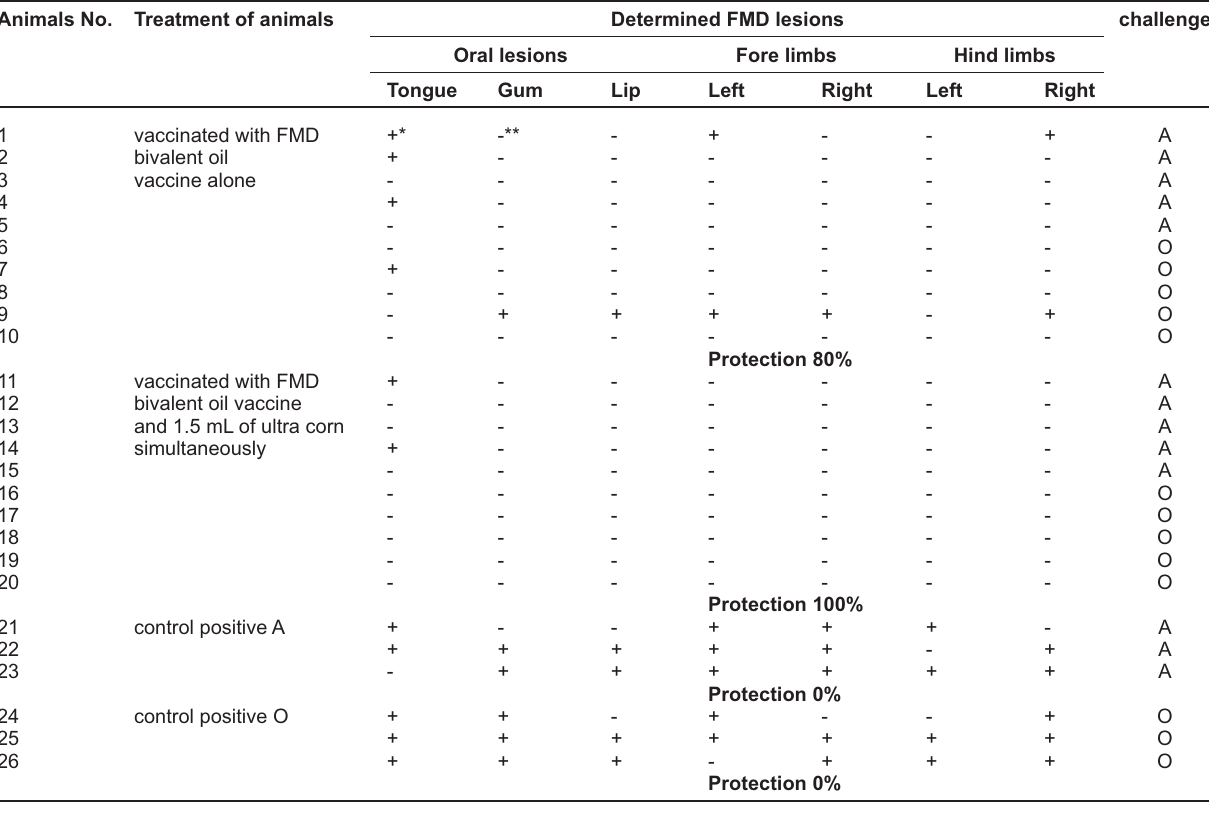
Table-5. Determine FMD lesions and protection percentage in calves vaccinated with bivalent FMD and 1.5 mL/ 100Kg body weight ultra-corn simultaneously after challenge against both types of FMD